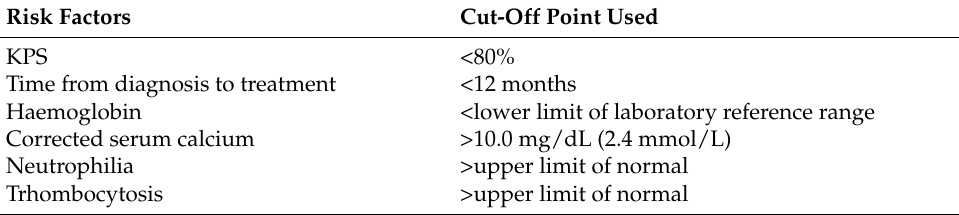
Table 2. International Metastatic RCC Database Consortium (IMDC) renal cancer prognostic